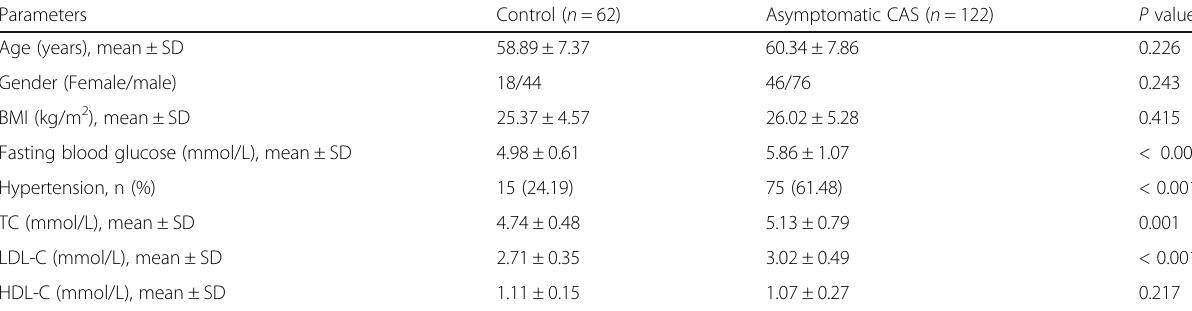
Table 1 Clinical data comparisons between healthy control and ACAS patients groups Parameters